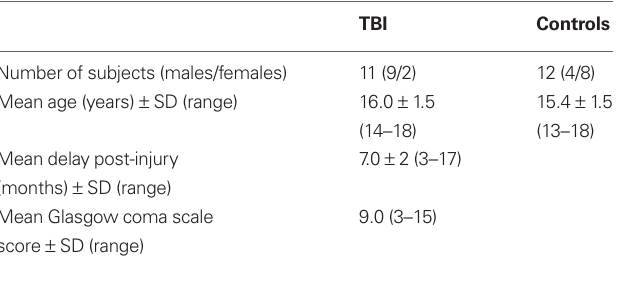
Table 1 | Description of TBI and Control groups for the cross- sectional study.